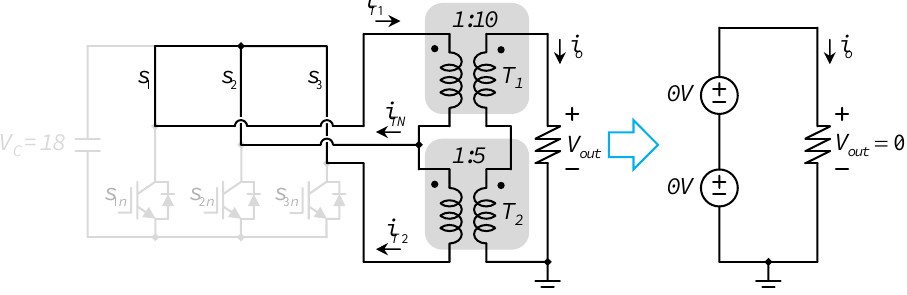
( a ) when the load current is positive and ( b ) when the load current is negative.